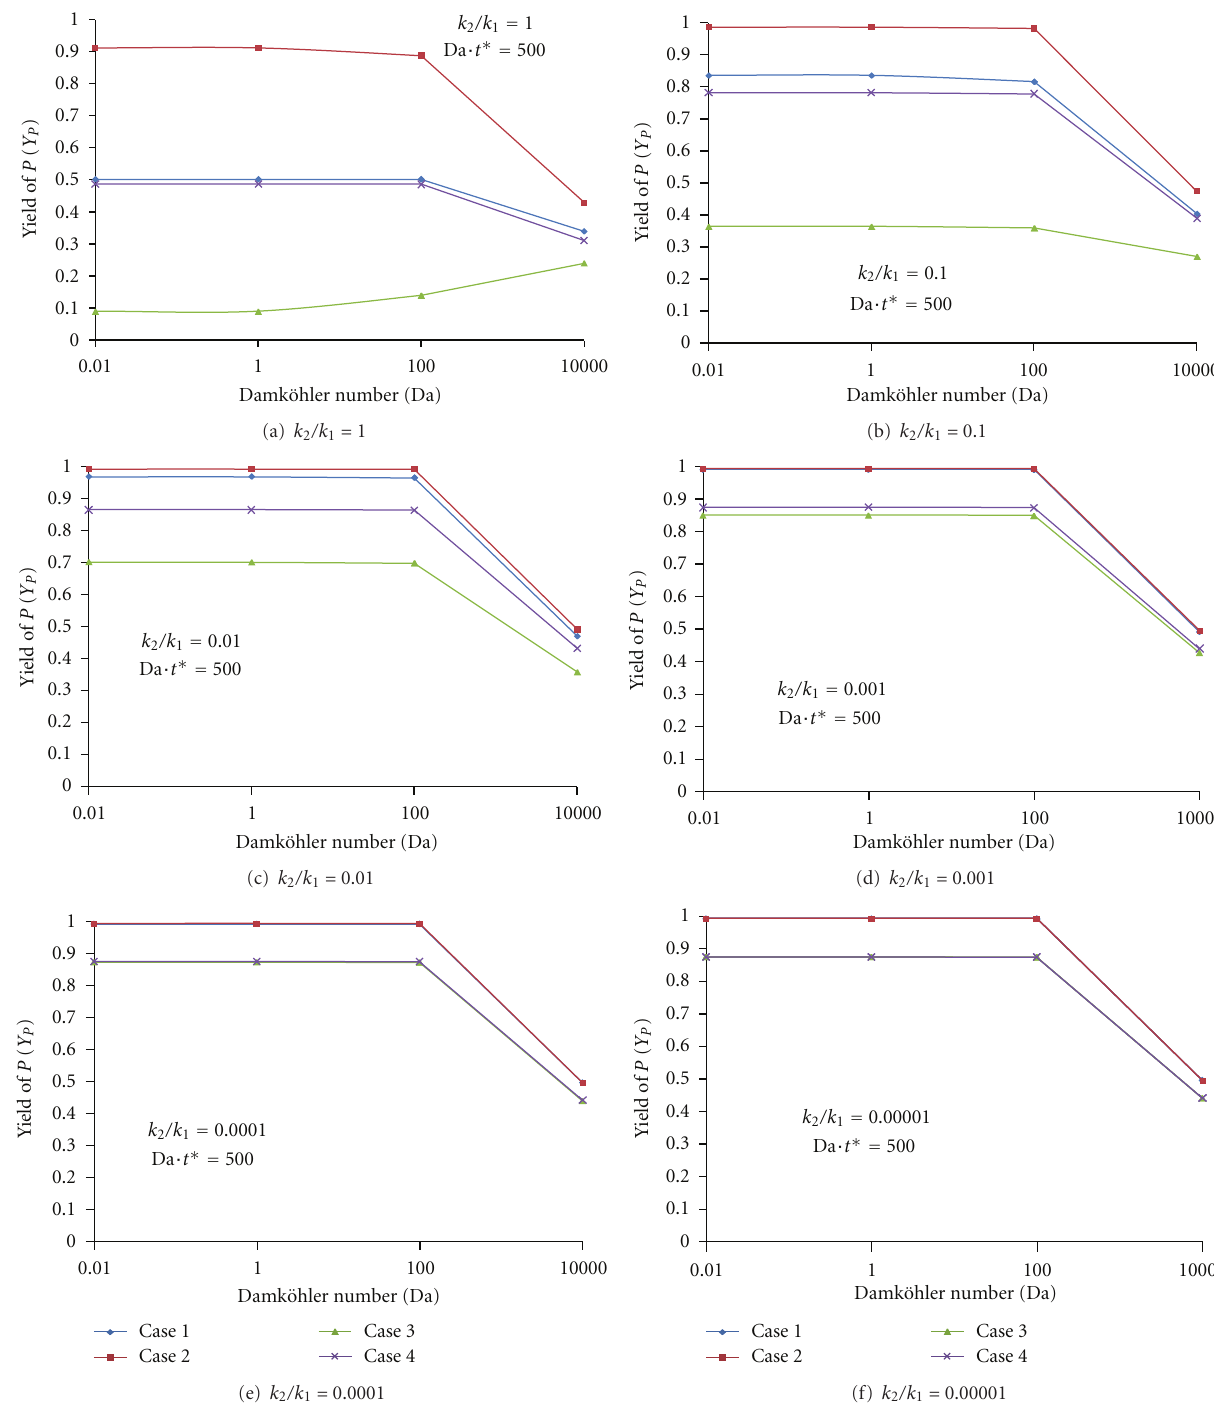
Figure 6: Plots of yield of P versus Da for decreasing k 2 / k 1 ratios for the C-P